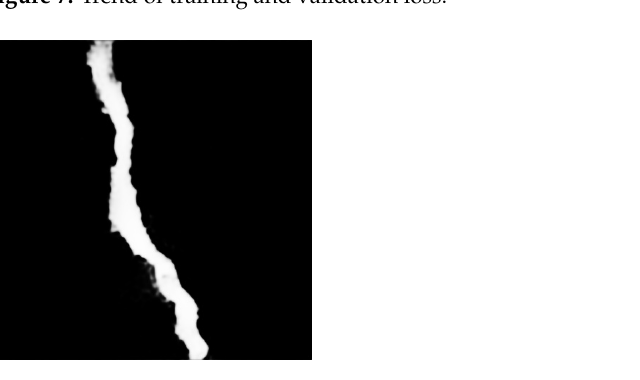
Figure 8. Crack detection result from Figure 1a, obtained using our proposed model.